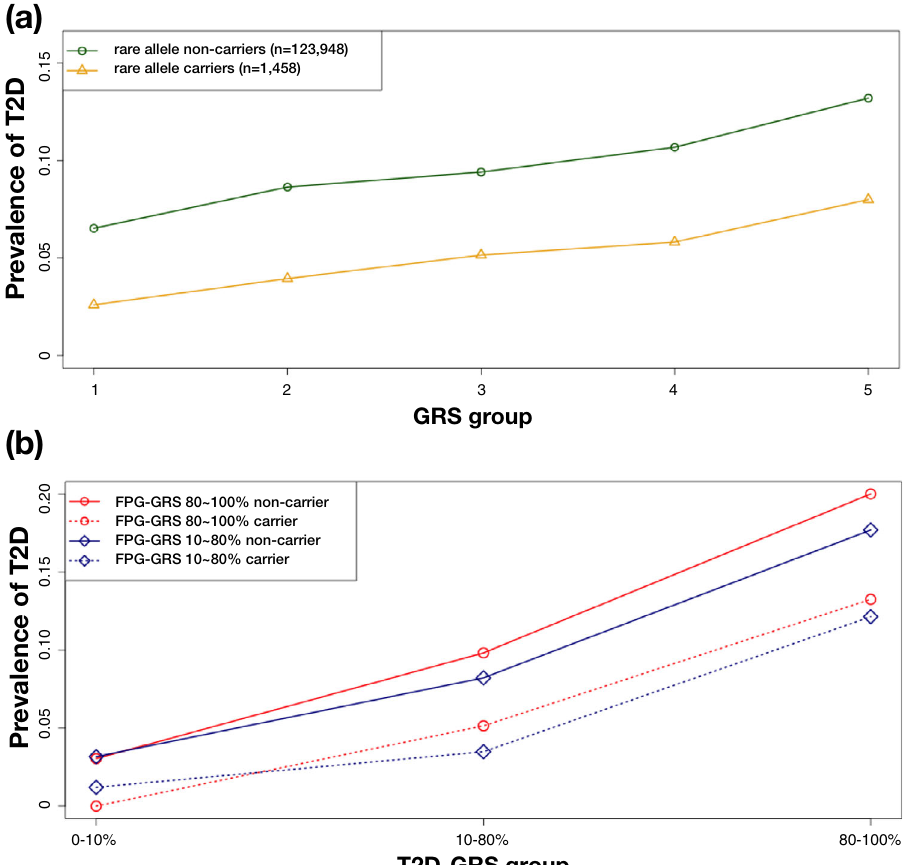
Fig. 4 | Interplay of common and rare variants in inherited risk of T2D. After sorting CV-GRS scores in an increasing order, CV-GRS bins were categorized as 1st bin (1 – 20%), 2nd bin (21 – 40%), 3rd bin (41 – 60%), 4th bin (61 – 80%), and 5th bin (81 – 100%). For rare allele carriers and non-carriers, all samples of KBA were